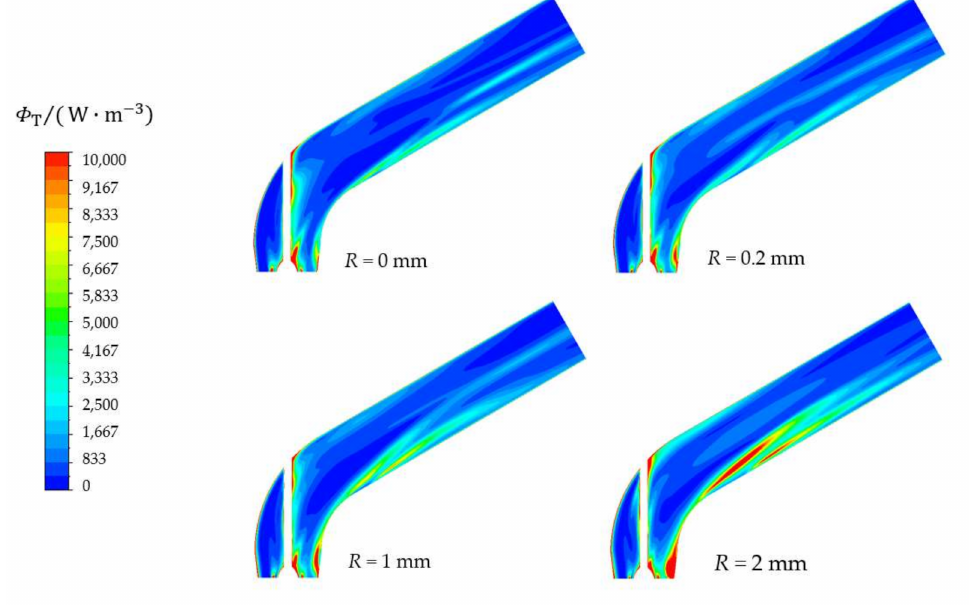
Figure 18. Distribution of internal dissipation rate in outflow passage under pump